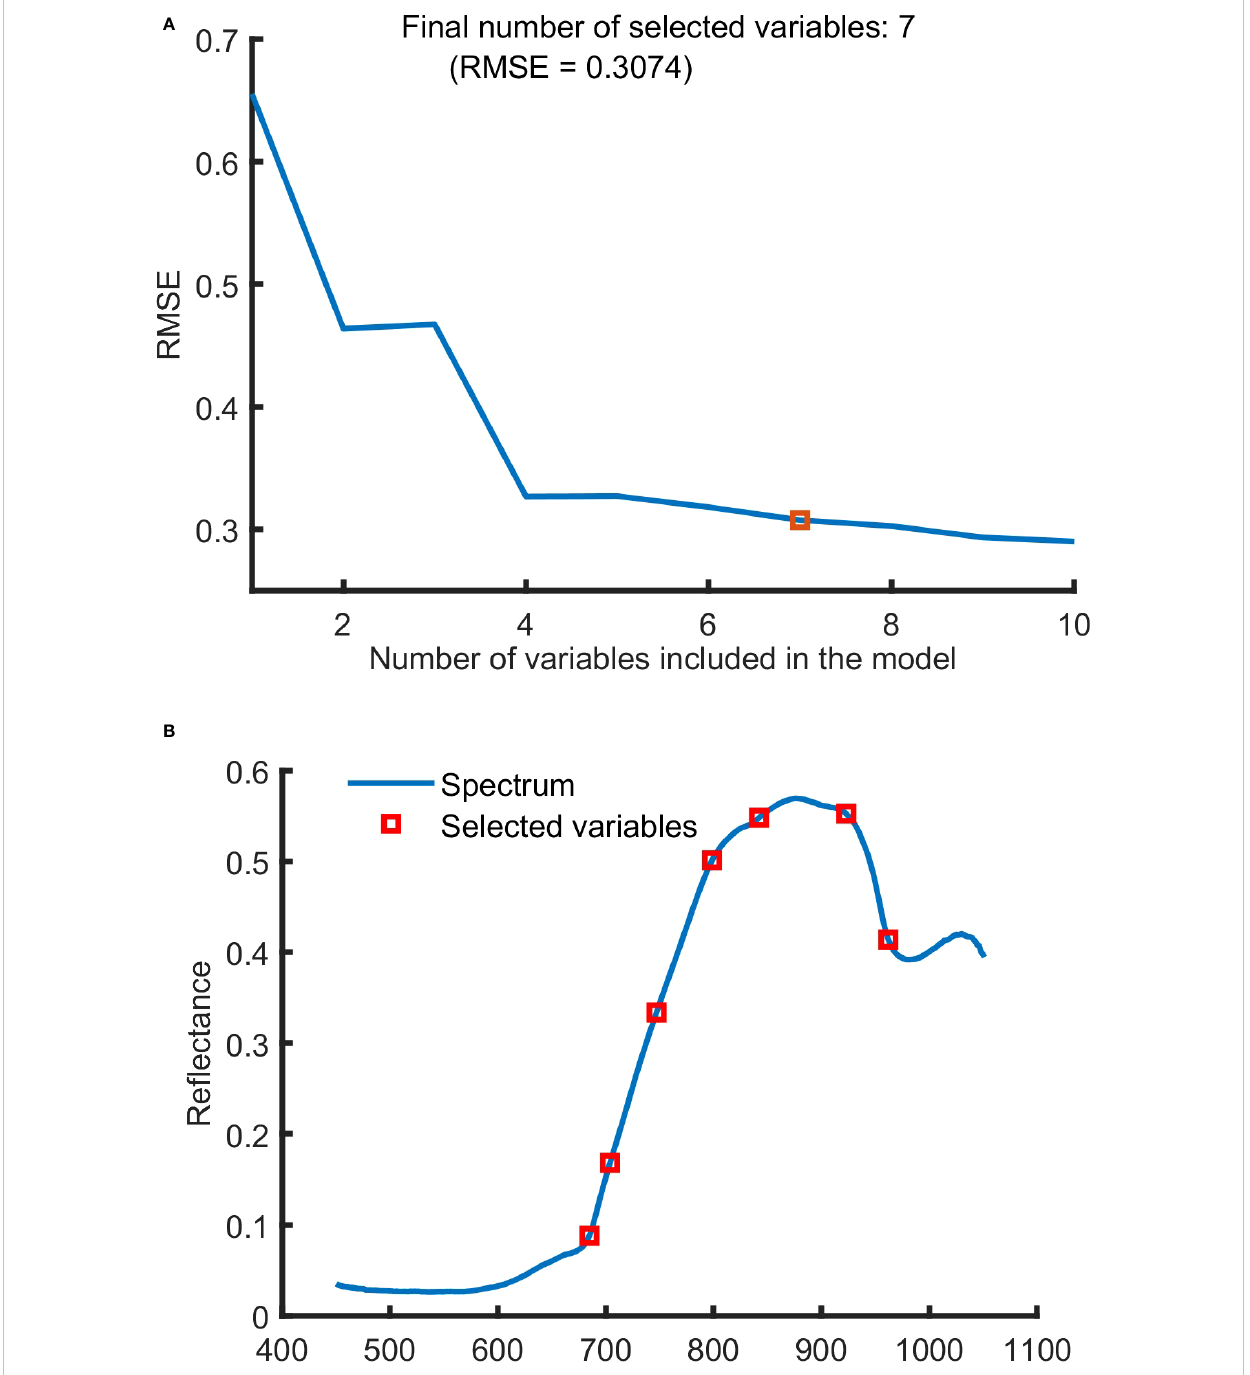
FIGURE 5 The characteristic wavelengths selected by SPA. (A) Variation of RMSE with the number of variables, (B) the selected